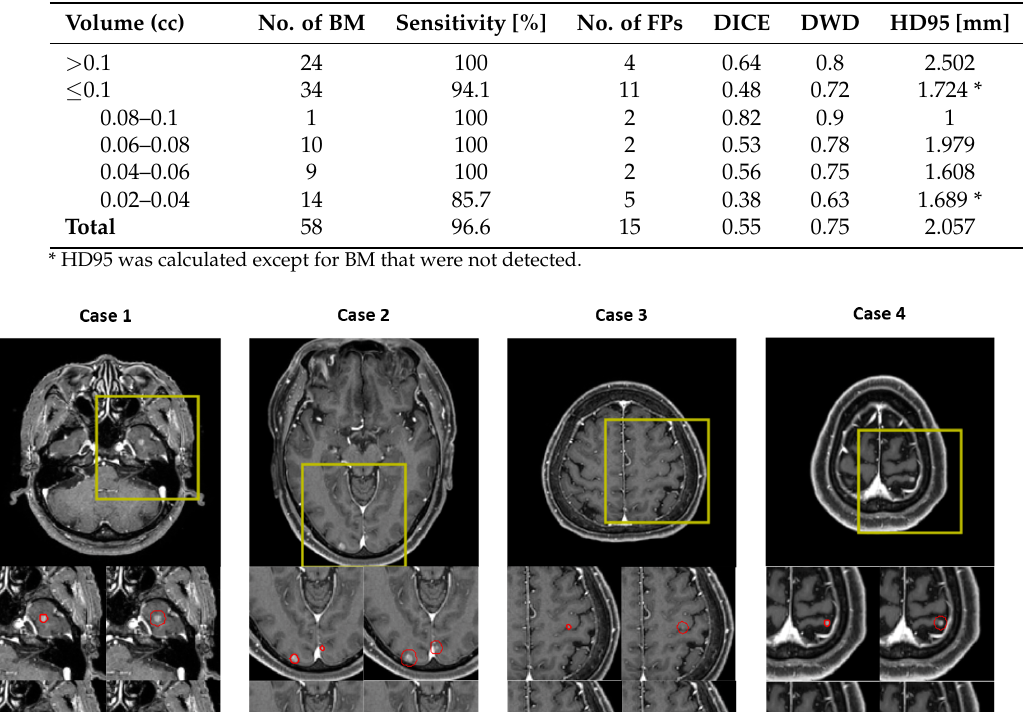
Table 3. Summary of Detection and Segmentation Performance.